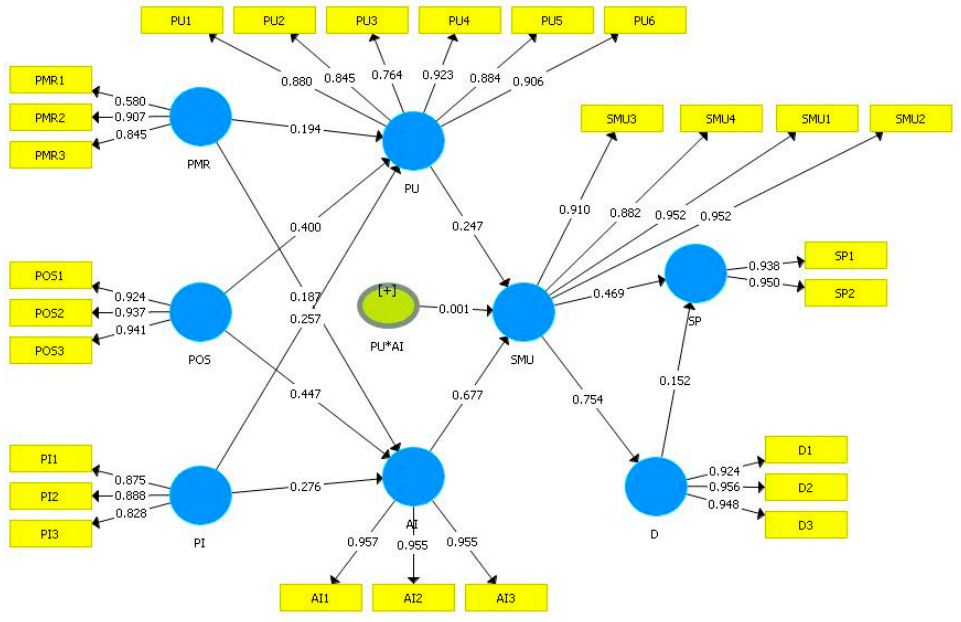
Figure 4. SmartPLS software output in standard mode.